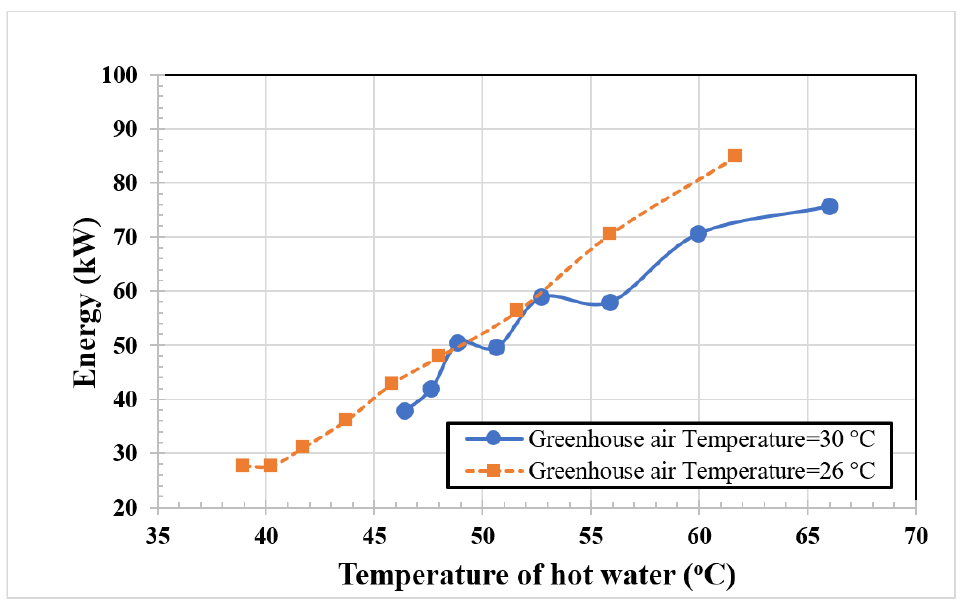
Figure 11. Energy consumption at two levels of greenhouse air temperature.